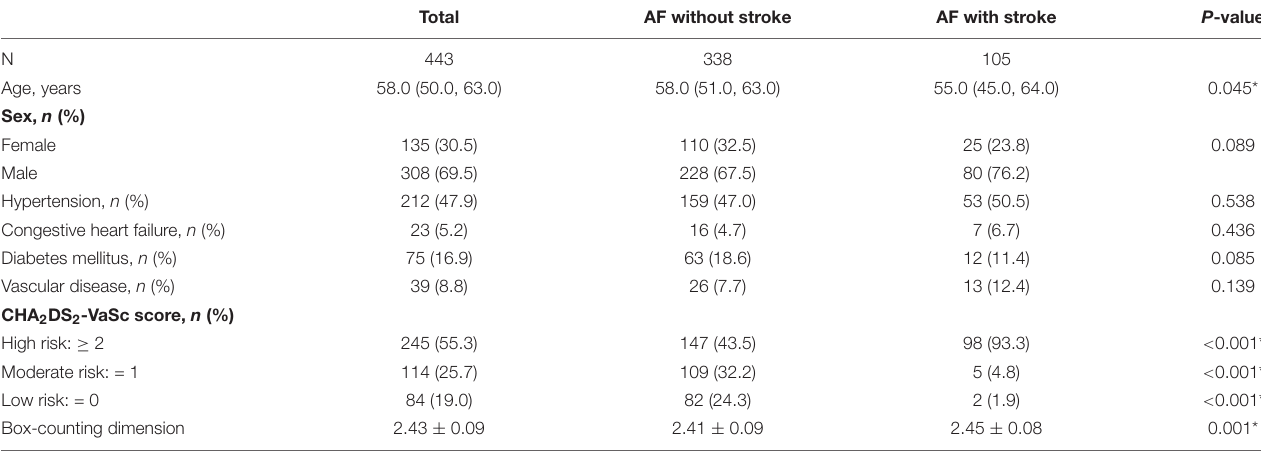
TABLE 2 | Clinical characteristics of patients with AF and with and without